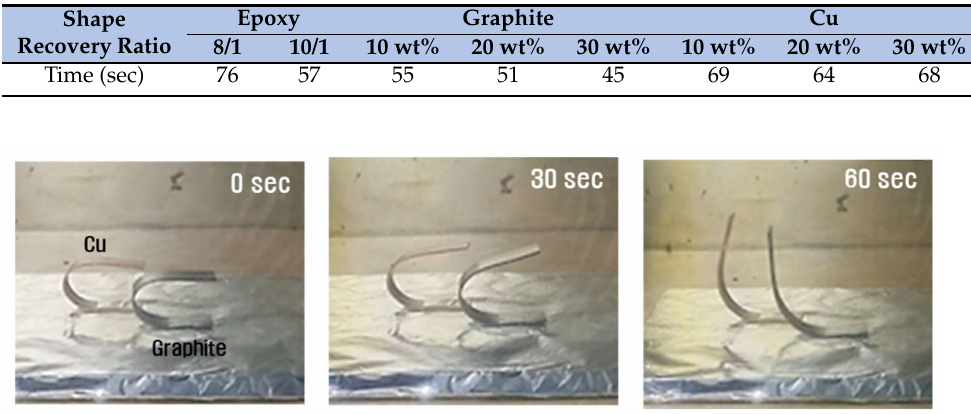
Figure 11. Snap shots of shape recovery performance by type of